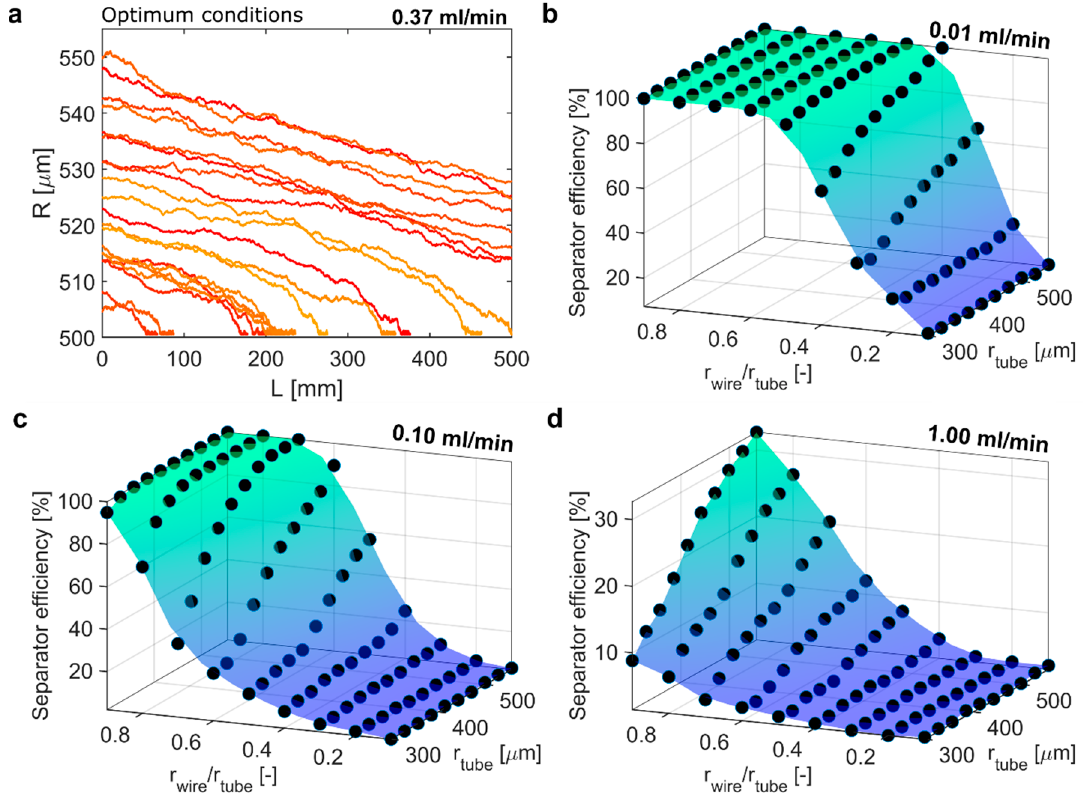
Figure 6. ( a ) 20 particle trajectories (out of 10,000) for the optimum separation condition for 500 nm MNPs yielding >80% separator efficiency at 0.37 mL/min ( r tube = 555.6 µ m, r wire = 500 µ m, r wire / r tube = 0.9). Separator efficiency of 500 nm IONPs for different separator dimensions operated at ( b ) 0.01 mL/min, ( c ) 0.1 mL/min, and ( d ) 1 mL/min.